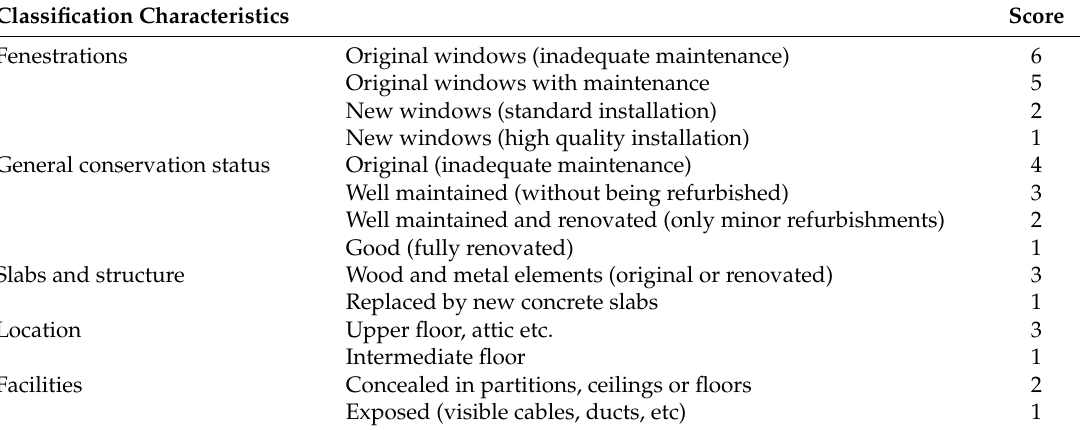
Table 7. Proposed weighting factors to classify the airtightness of an enclosure due to its characteristics. Classification